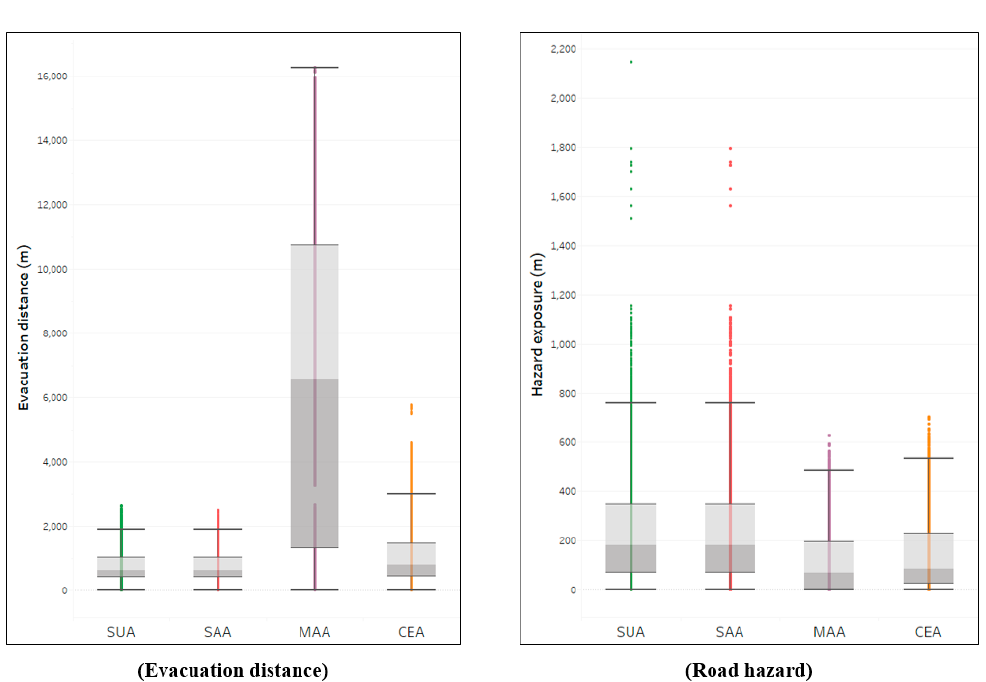
Figure 6. Evacuation distance and road hazard for each route analysis.